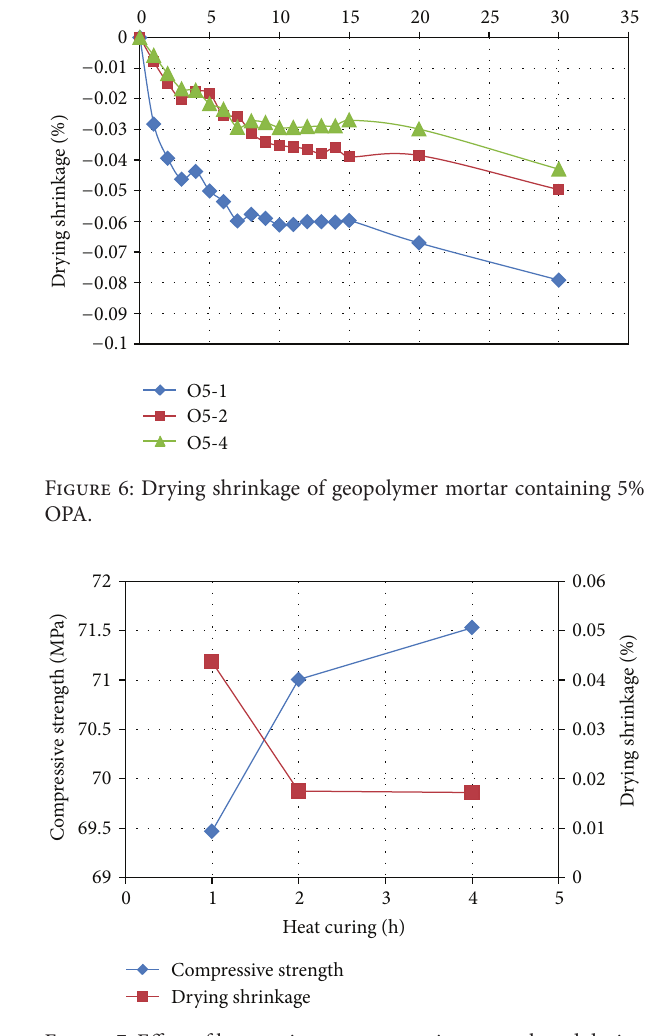
Figure 7: Effect of heat curing on compressive strength and drying shrinkage of samples with 5% OPA at 28